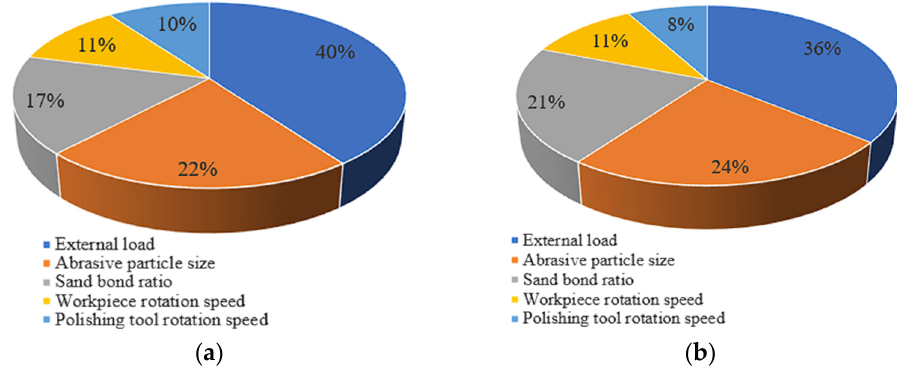
Figure 9. Influence percentage of each factor to surface roughness ( a ) and material removal rate MRR ( b ). Table 3. Intuitive analysis table for surface roughness R a.